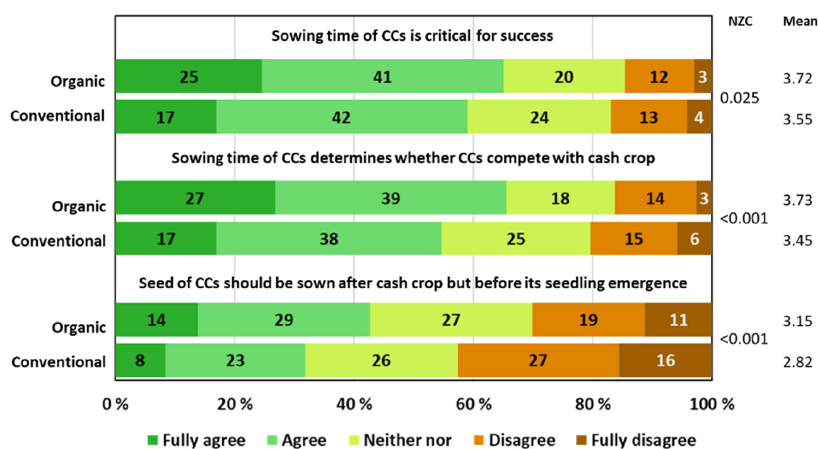
Figure 6. The distribution of farmers’ answers (N = 1130) depending on the farming system (NZC, nonzero correlation; CCs, cover crops).